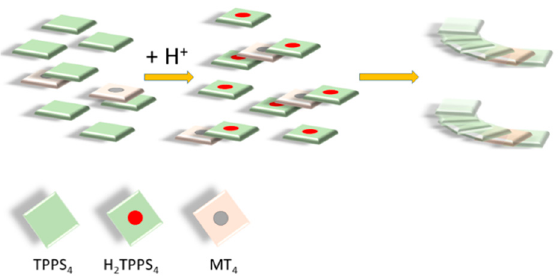
Scheme 1. Pictorial sketch of TPPS 4 protonation and subsequent J-aggregation in the presence of cationic metallo-porphyrins MT 4 .